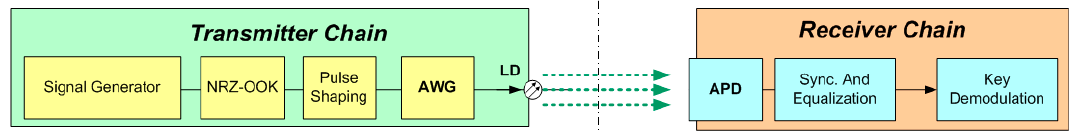
Figure 2. Short Range Optical Communication System: transmitter / receiver chain.